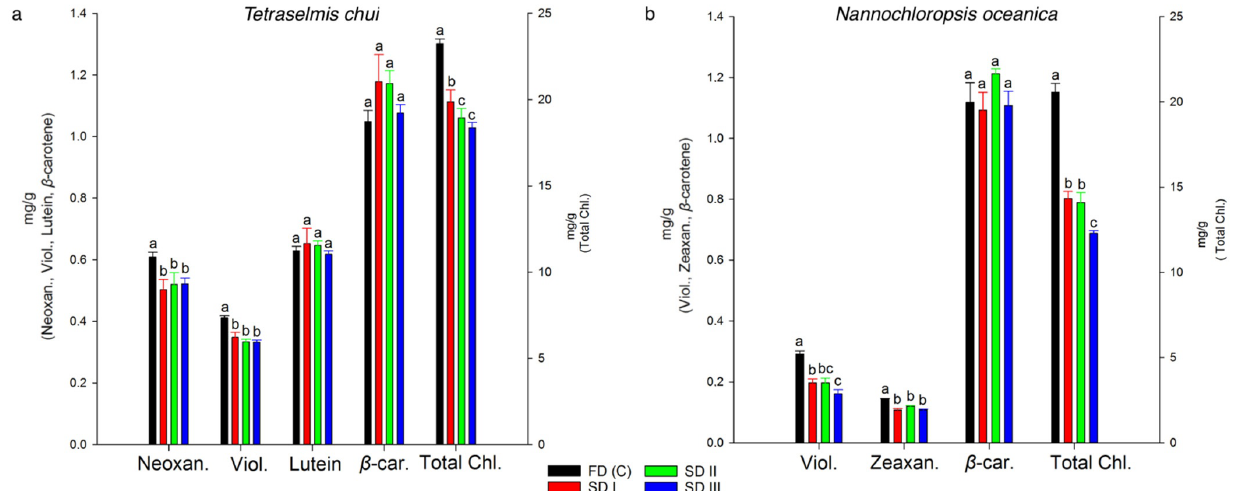
Figure 4. Total neoxanthin, violaxanthin, lutein, β -carotene, and total chlorophyll contents of solar- (SD I, II, and III) and freeze-dried (FDc) Tetraselmis chui ( a ). Total violaxanthin, zeaxanthin, β -carotene, and total chlorophyll contents of solar- (SD I, II, and III) and freeze-dried (FDc) Nannochloropsis oceanica ( b ). Different letters represent significant differences detected by Tukey’s post hoc range test (HSD, ANOVA). Data points for solar- and freeze-dried samples are shown as mean ± Std Dev ( n = 3). Error bars represent standard deviations.